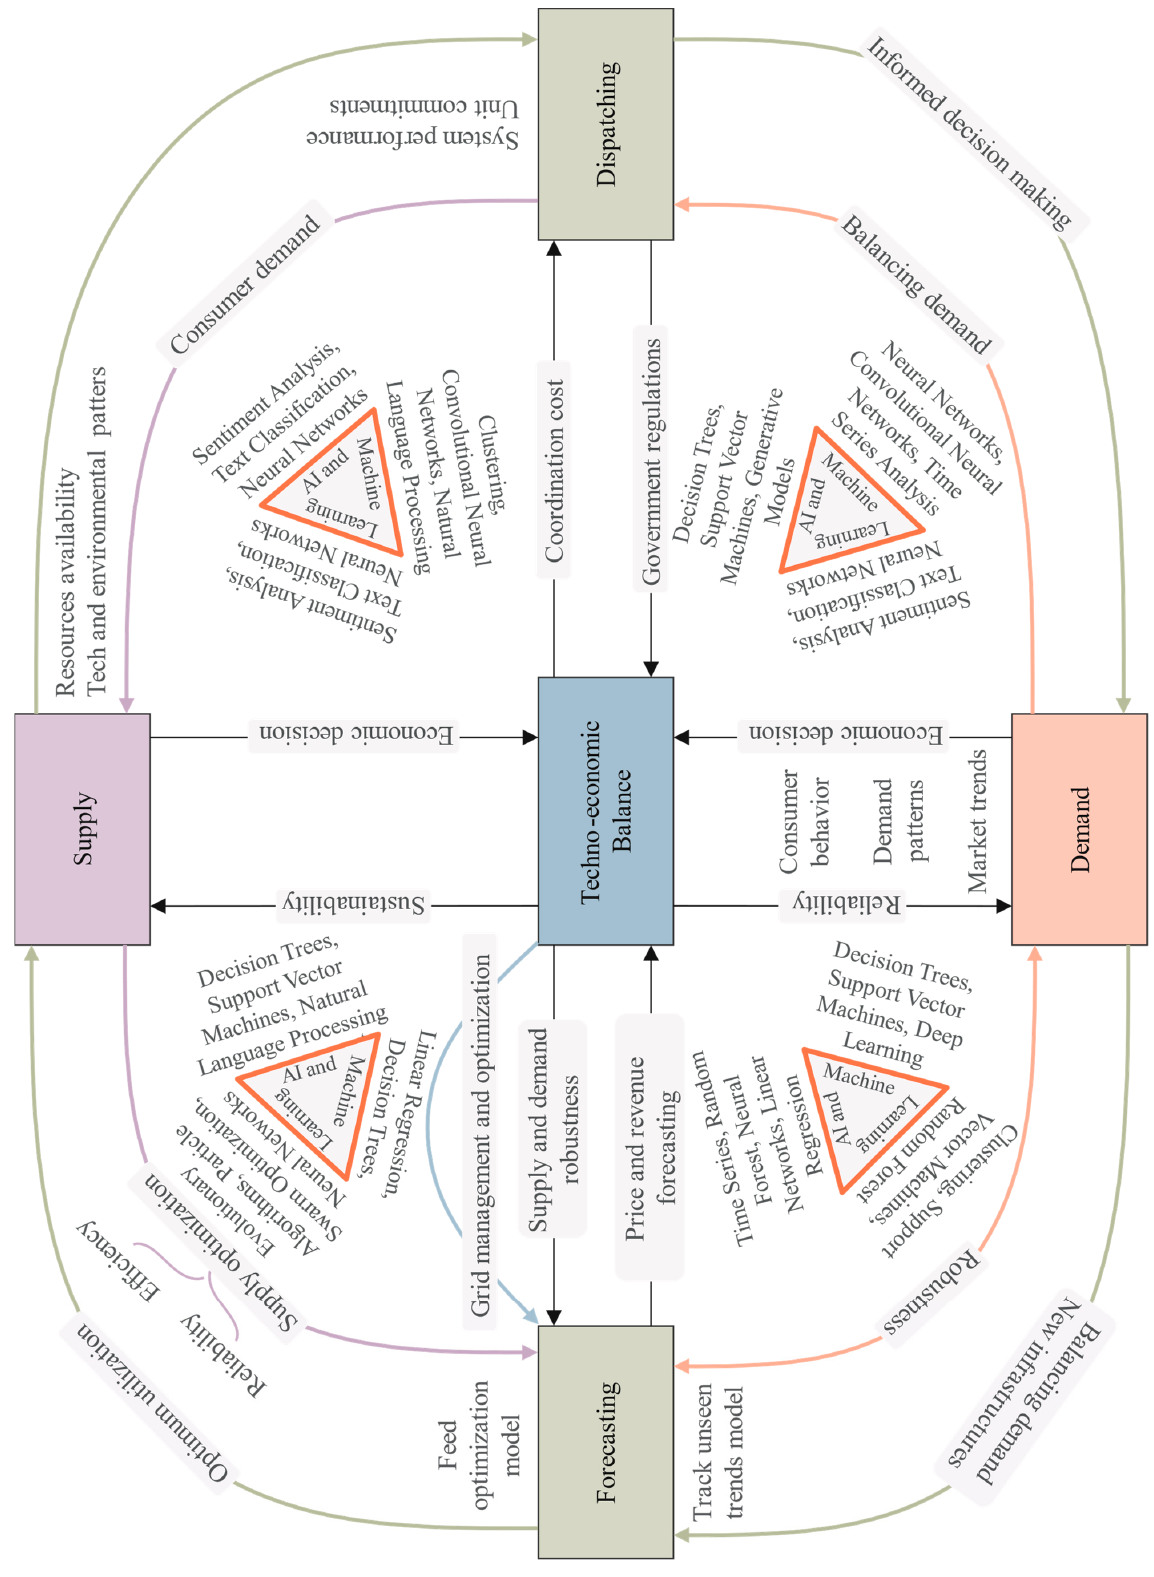
Figure 4. An overview of the techno-economic energy balancing landscape highlighting the integra- tion of AI and ML into various energy system applications by distinguishing the triangle of AI and ML methods.